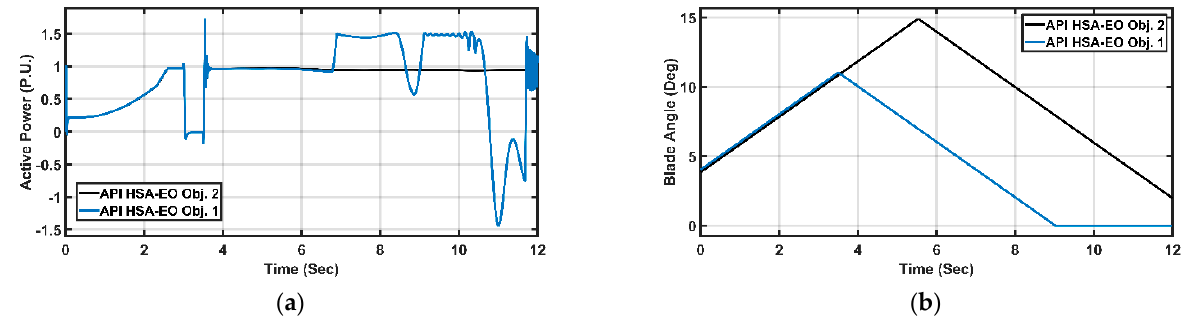
Figure 32. ( a ) Active power responses of faulty third case. ( b ) Blade-angle responses of faulty third case. The numerical comparisons of the controllers are listed in Table 15. The settling time and the negative peak of the API with objective two are lower than that of the API with objective one. Table 16 shows the active power statistical analysis of each controller.